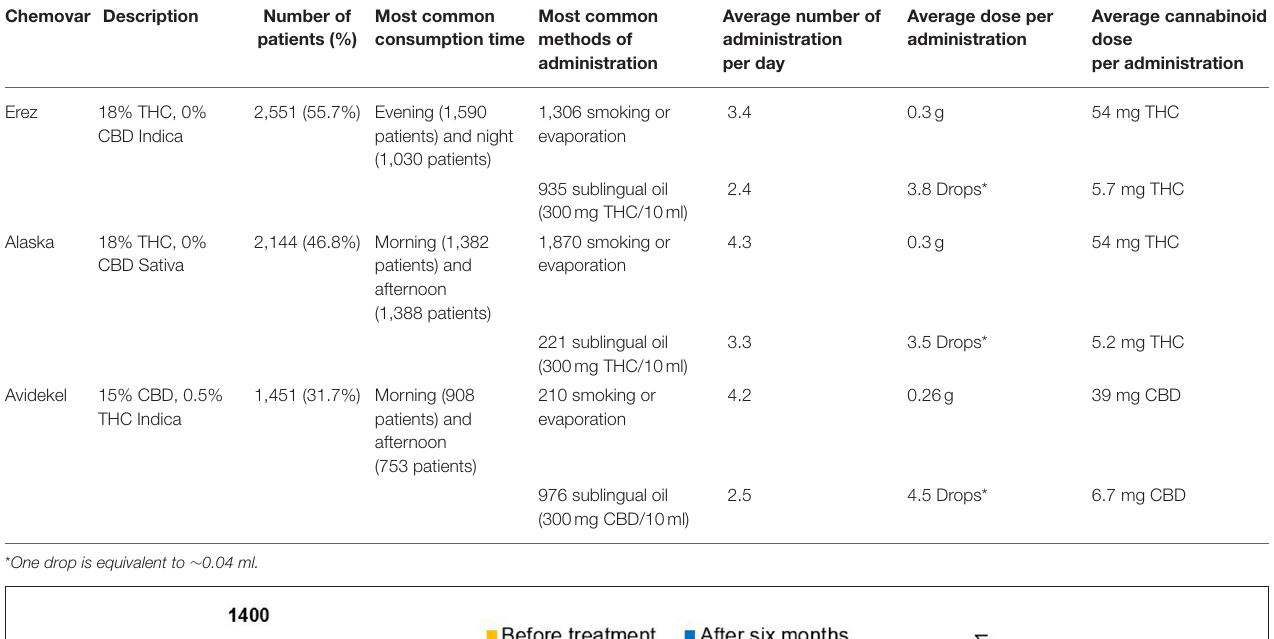
Most common Most common patients (%) consumption time methods of